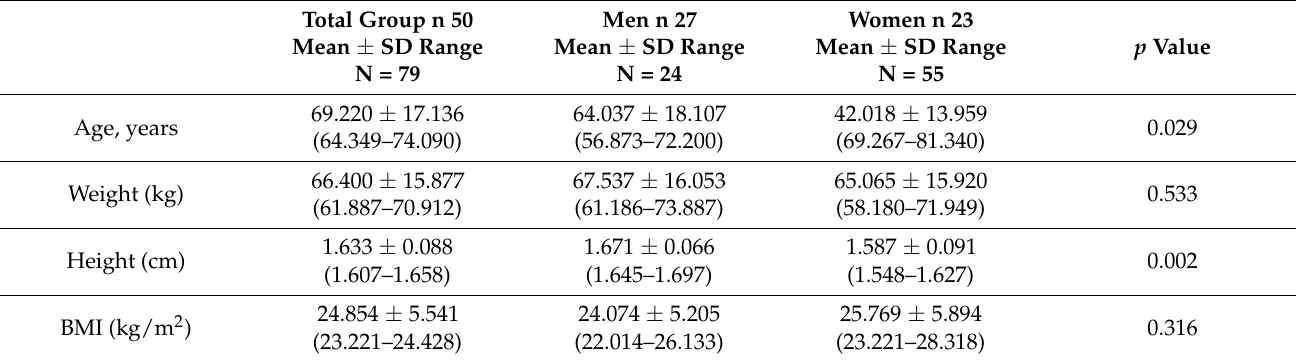
Table 1. Sociodemographic characteristics of the sample